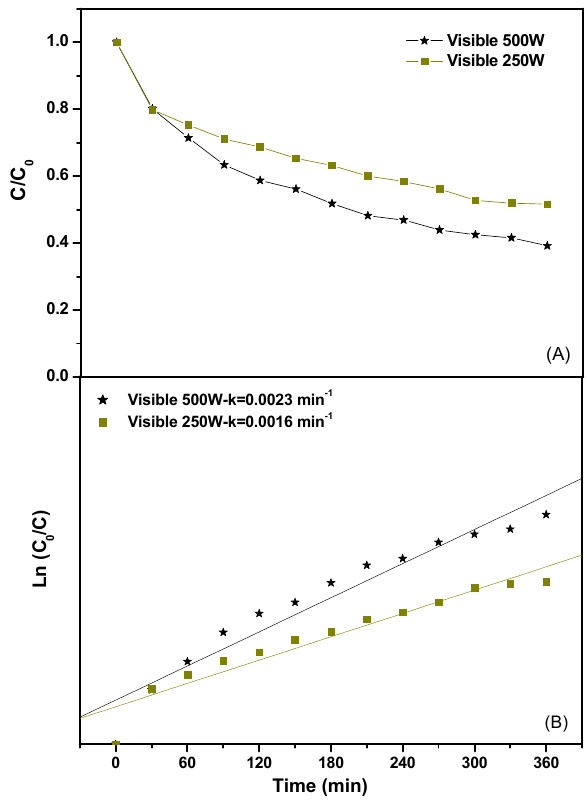
Figure 15. Effect of the light intensity on the photocatalytic degradation efficiency of Direct Red 23 ( A ); and the first-order kinetic plots for the photocatalytic degradation of Direct Red 23 ( B ) with different light intensity under visible light irradiation.